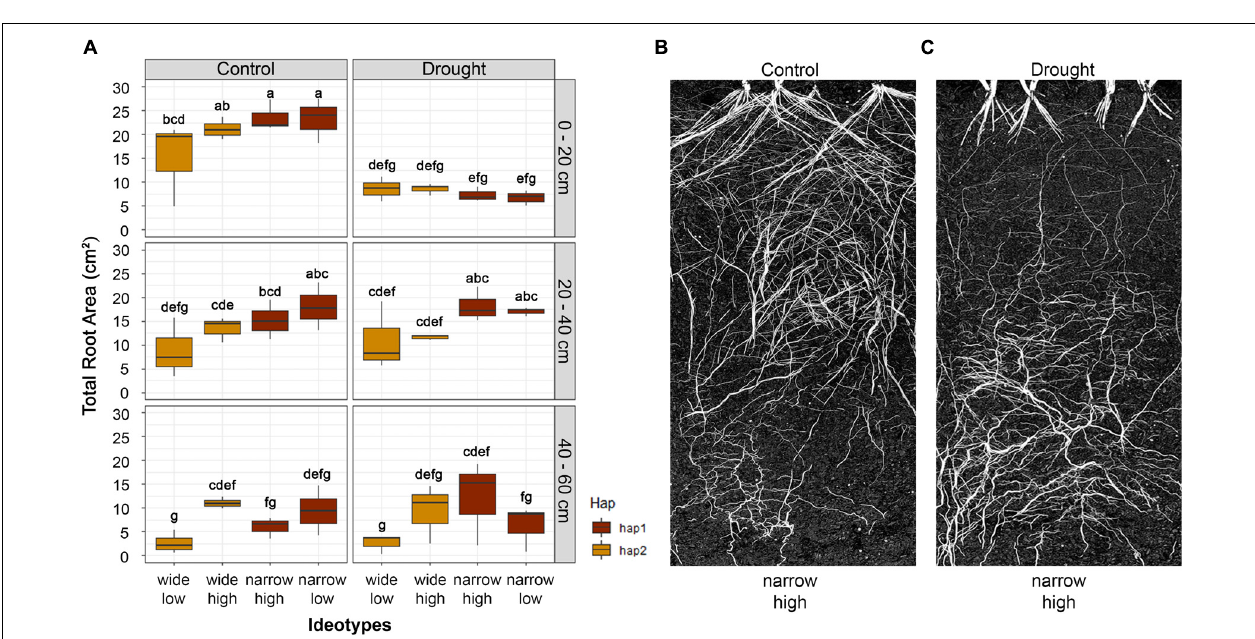
FIGURE 7 | Root area distribution of the four root ideotypes wide-low, wide-high, narrow-high and narrow-low at different depths of the growth chamber. (A) Boxplots display root distribution of the four ideotypes under control (well-watered) and drought conditions. The colors represent the two haplotype groups of the root angle qSRA-6A. Letters above boxplots indicate significance difference between the four root ideotypes using least significant difference (LSD) test at α = 0.05. Visualization of a narrow-high root ideotype under (B) controlled (well-watered) and (C) drought conditions is shown.